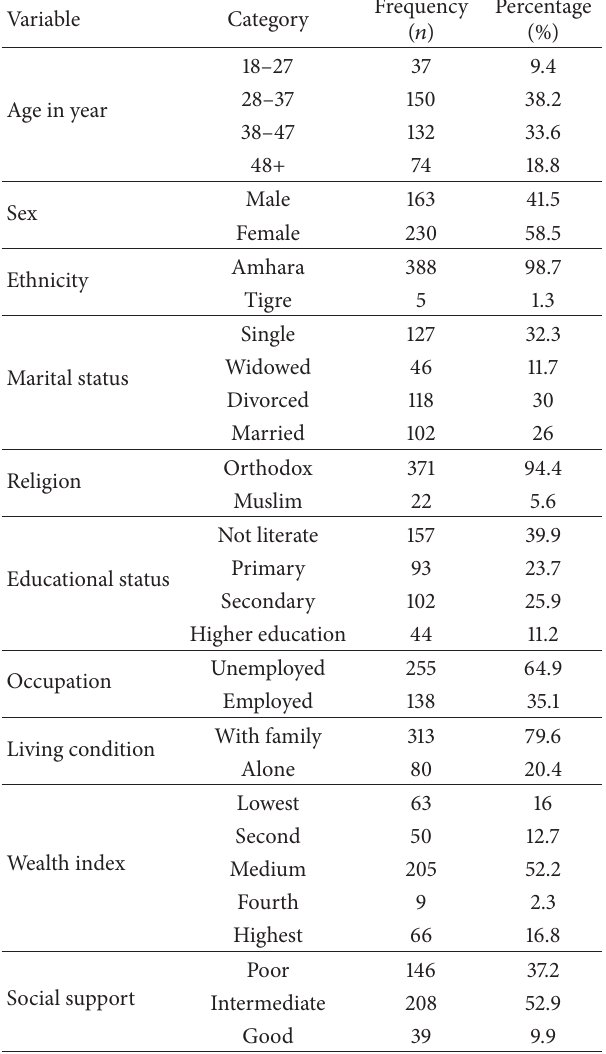
Table 1: Sociodemographic characteristics of HIV patients at Debark Hospital Northwest, Ethiopia, 2015 ( 𝑛 = 393